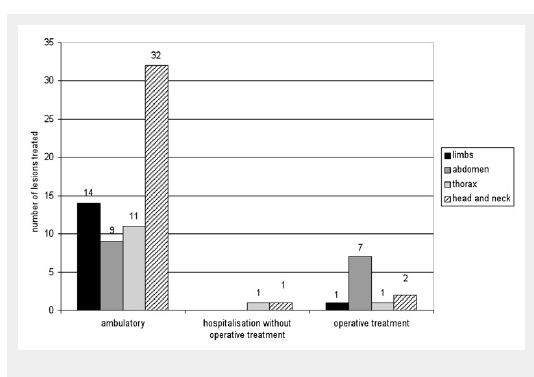
Type of transportation to the ED in our cohort of 80 consecutive stab injuries.